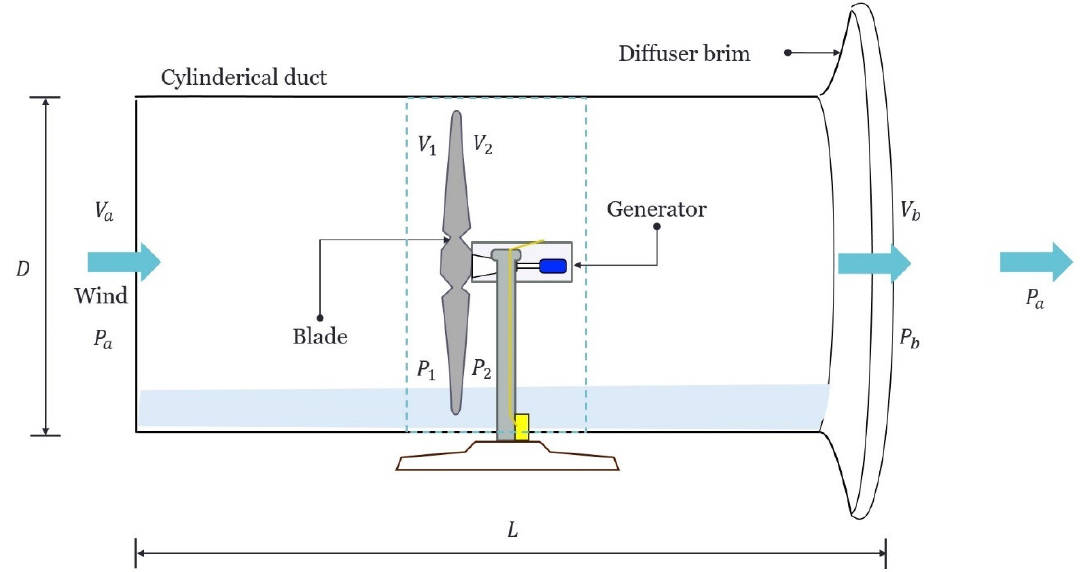
Figure 1. The proposed ducted micro wind energy harvester. Table 1. Design parameters.